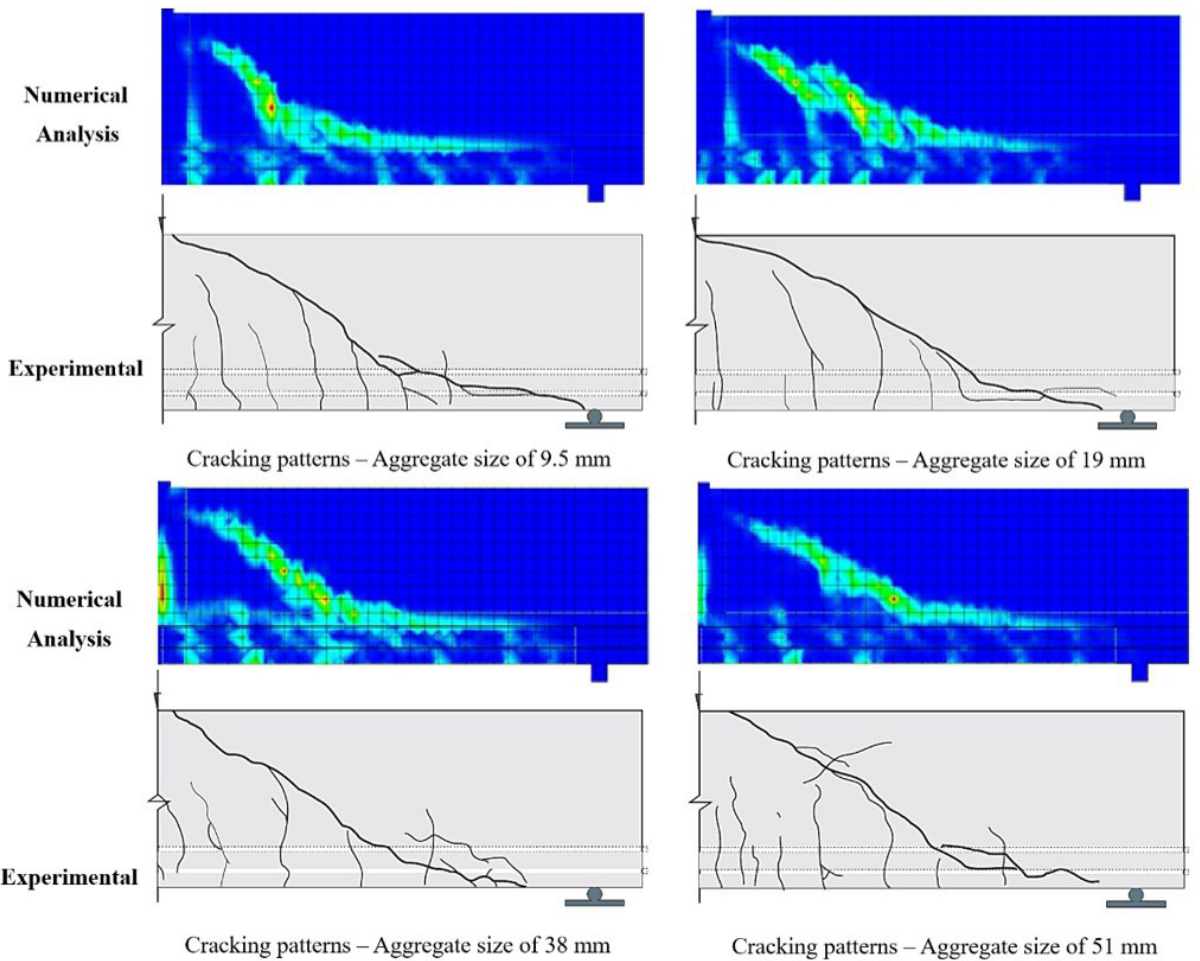
Figure 8. Numerical and experimental comparison for S-Series